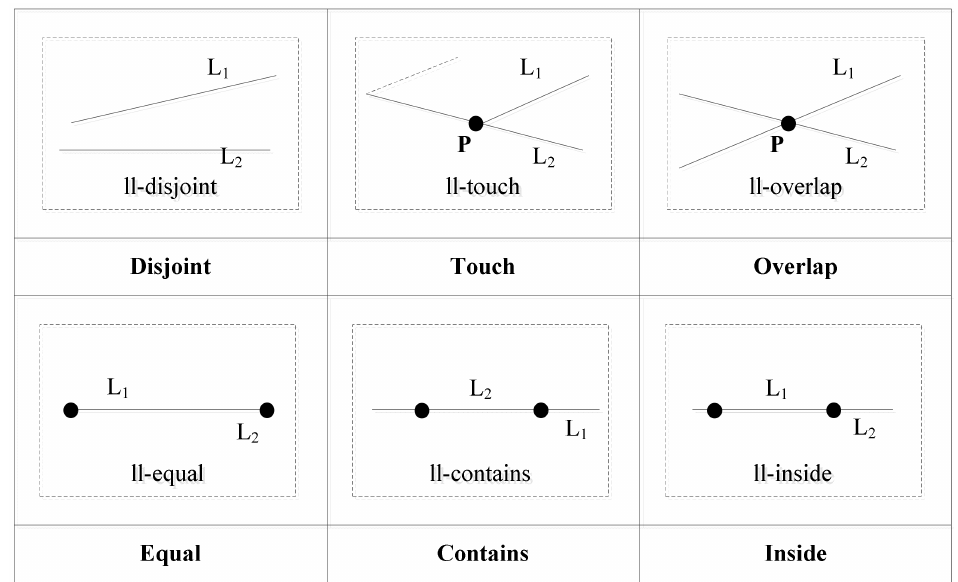
Figure 9. Topological relations between two line segments.